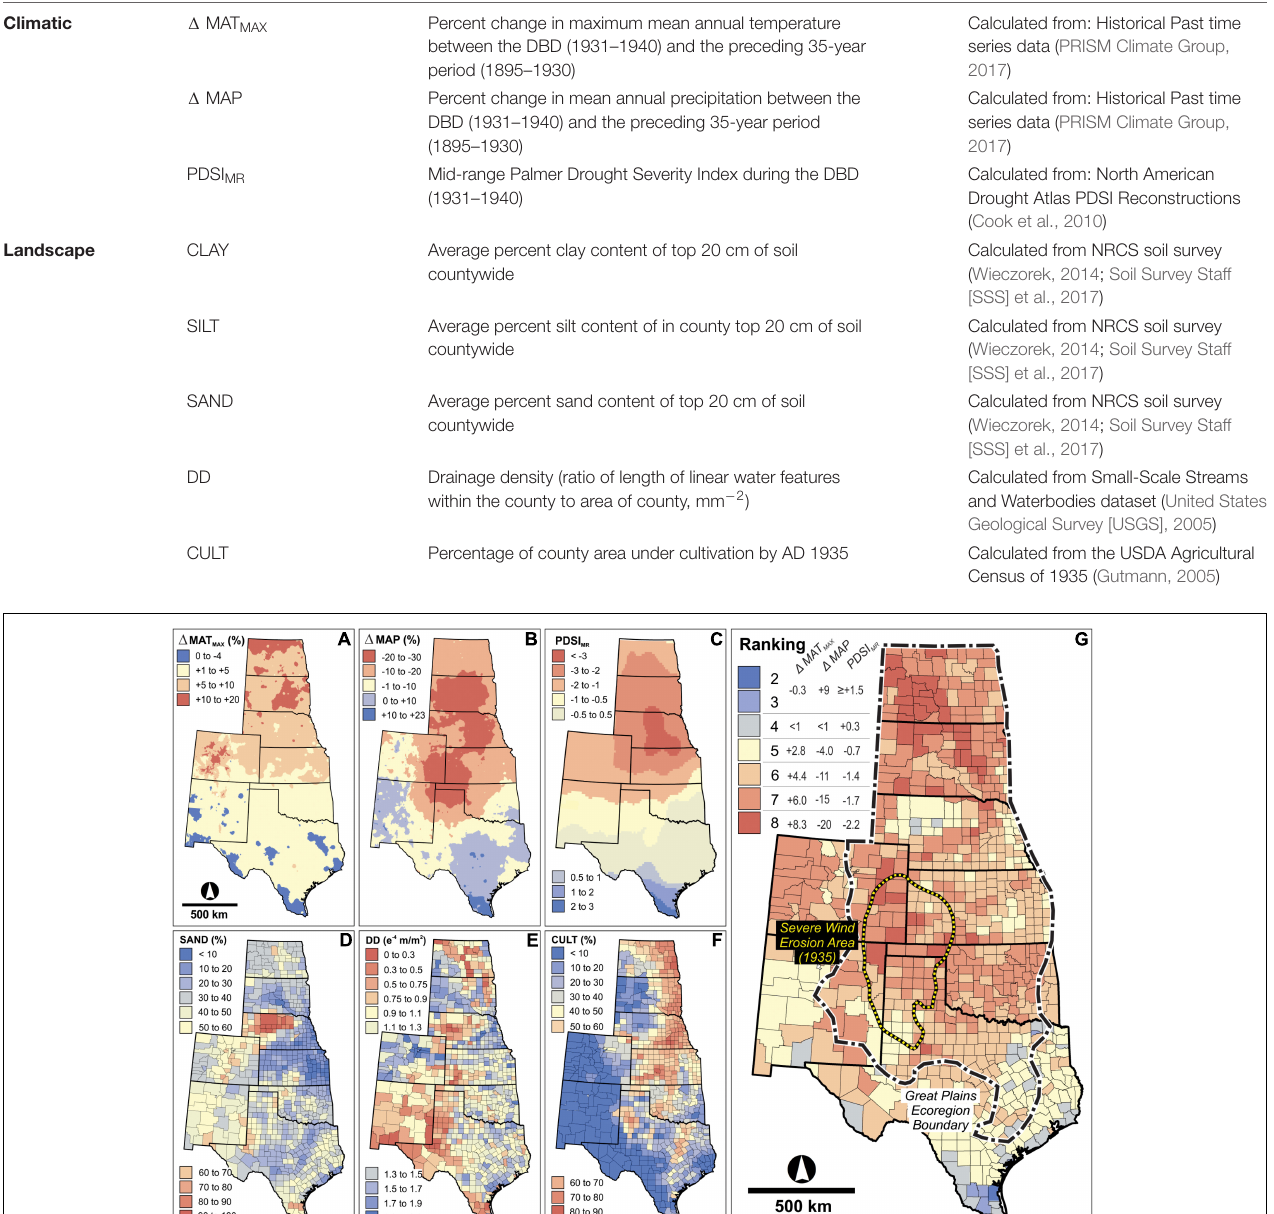
Three physical surficial parameters averaged at the county level were included to evaluate the similarity of landscape setting amongst counties within the same ecoregion, with values closest